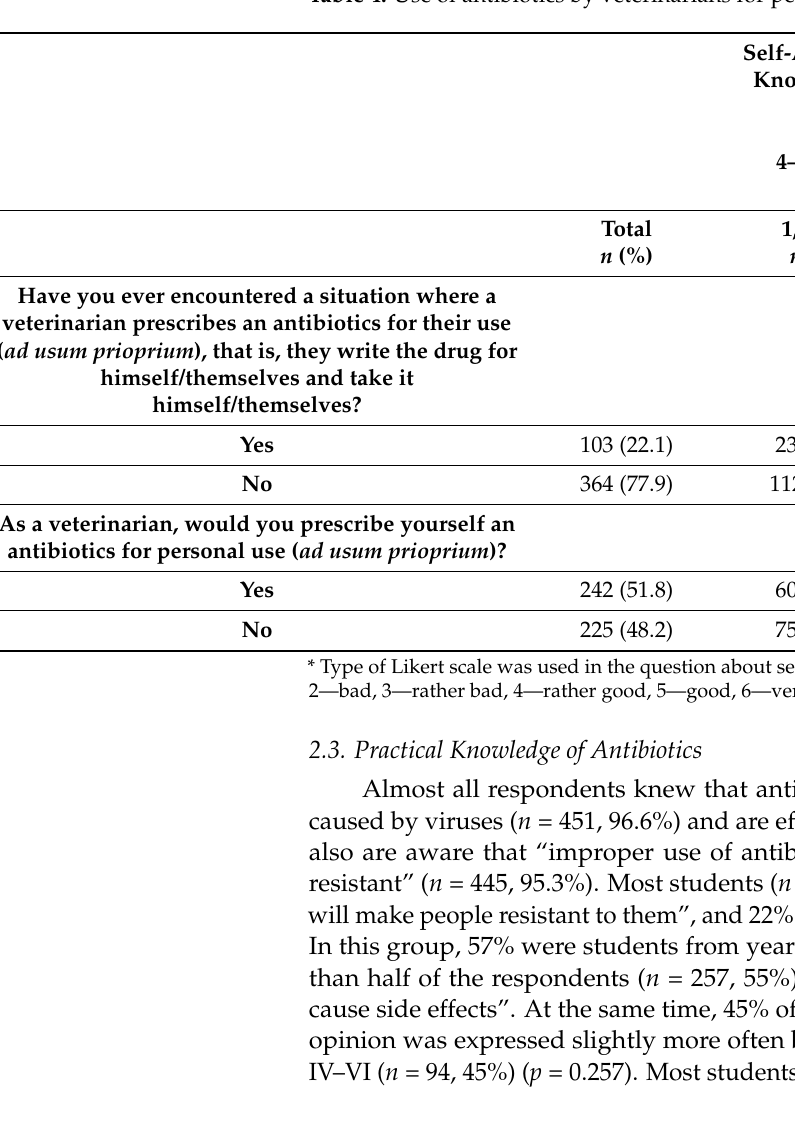
Table 4. Use of antibiotics by veterinarians for personal use ( n =